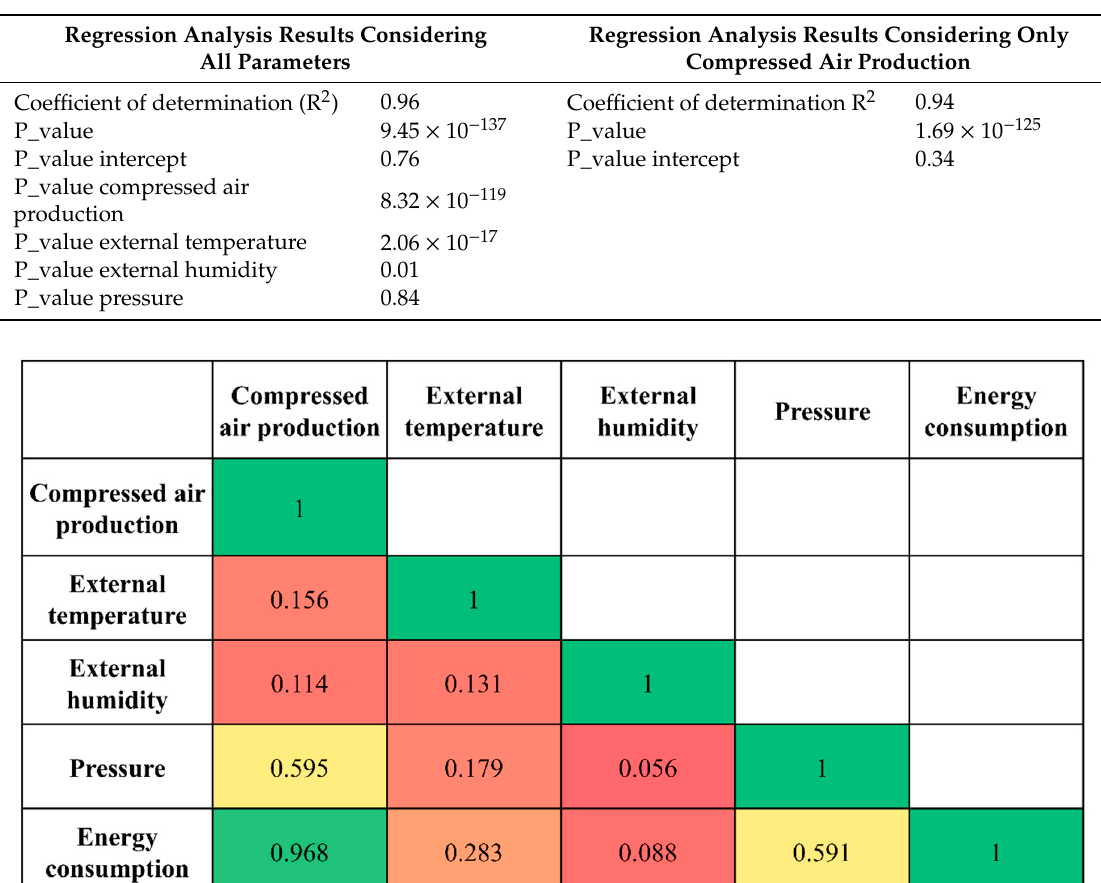
Figure 8. Scatterplot representing the relation between energy consumption and compressed air production. The CuSum and the control chart for the energy performance deviations for the data collection period (Step 8) are given in Figure 9 and their joint observation shows the presence of four energy behaviors, highlighted using different colors. Indeed, the CuSum in Figure 9a shows four different trends clearly distinguishable and the control chart for the energy performance deviations in Figure 9b displays four different distributions with a different mean.